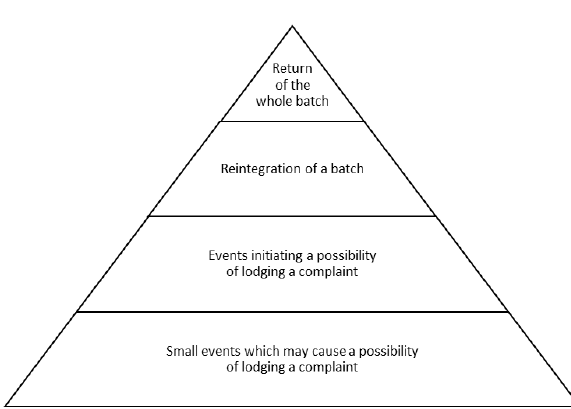
Figure 4: Pyramid of events of complaints Source: B. Eckhardt